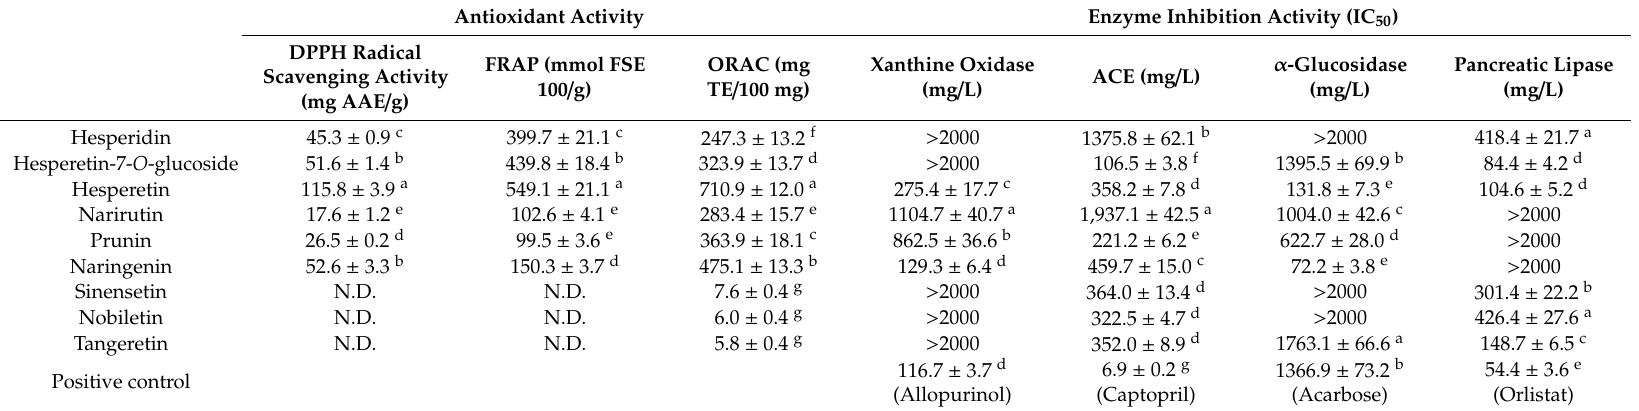
Table 4. Antioxidant activities and enzyme inhibitory activities of individual citrus